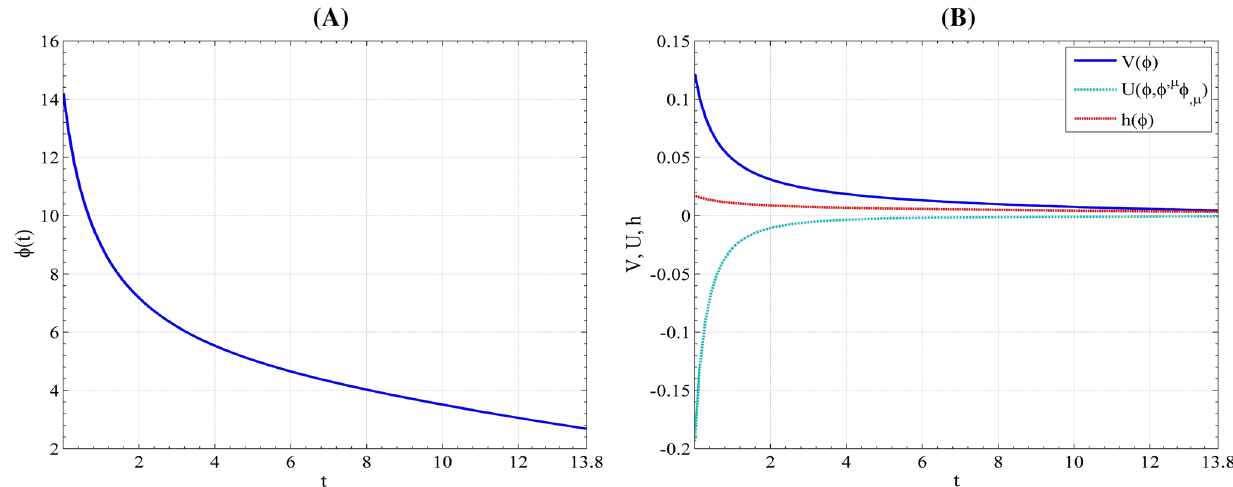
Fig. 4 Plot a indicates the scalar field ϕ( t ) versus time t at the time range [ 0 . 0006 , 13 . 816 ] and plot b shows coupling function U (ϕ,ϕ μ ϕ μ ) , h (ϕ) and the scalar potential V (ϕ) versus time t at the same time range